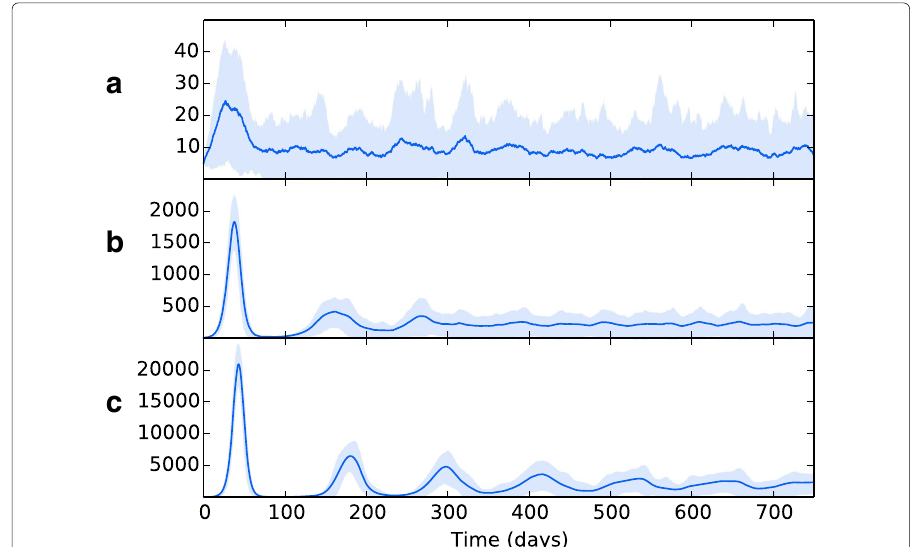
Fig. 6 The overall bacterial growth ( B ER , B ED , B IM and B ID ) within a single patch topology (Topology A) when perfusion is reduced to a 4.5, b 1.3, c 0.5. Line is mean, shading is standard deviation. Reducing perfusion allows a bacterial presence to be established. In a no major initial infection takes place and the infection level remains fairly constant throughout. In b a pattern similar to the reduced recruitment rate in Fig. 5 is seen. In c , the reduced perfusion results in a saw-tooth pattern, whereby latency is now involves an oscillating, rather than constant, level of